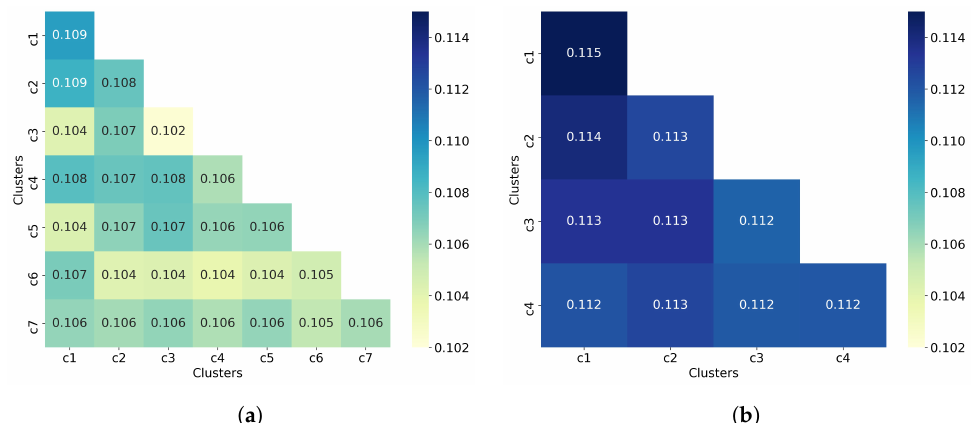
Figure 5. Hierarchical clustering with Ward linkage = 3. ( a ) Clustering of all 50,555 molecules results in 7 clusters. ( b ) The clustering of 32,971 non-outlier molecules results in 4 clusters. Outlier molecules were removed using an outlier cutoff of 0.5 (see Section 3.1 for more details about outlier detection). The matrix is calculated as the average Tanimoto similarity between the molecules of cluster i and those in cluster j , and the average similarity between molecules of a cluster and itself (see Section 2.3 for more details on how this matrix is calculated). The matrices have been adjusted to the same scale to facilitate clustering comparison between all molecules and non-outlier molecules. For readability, similarity scores were rounded to three decimal places. The average similarity between a cluster and itself (diagonal) is close to the average similarity between two different clusters (off-diagonal), indicating poor clustering of both all molecules and non-outlier molecules. Table 3. Better-defined clusters are obtained when using smaller similarity cutoff values, at the cost of a larger number of clusters. Clustering quality metrics were calculated for each similarity cutoff evaluated in the Taylor–Butina clustering. Non-outlier molecules were retrieved at an outlier cutoff of 0.5. The best value for each metric for either all molecules or non-outlier molecules is highlighted in bold. For readability, clustering quality results were rounded to either two or three decimal